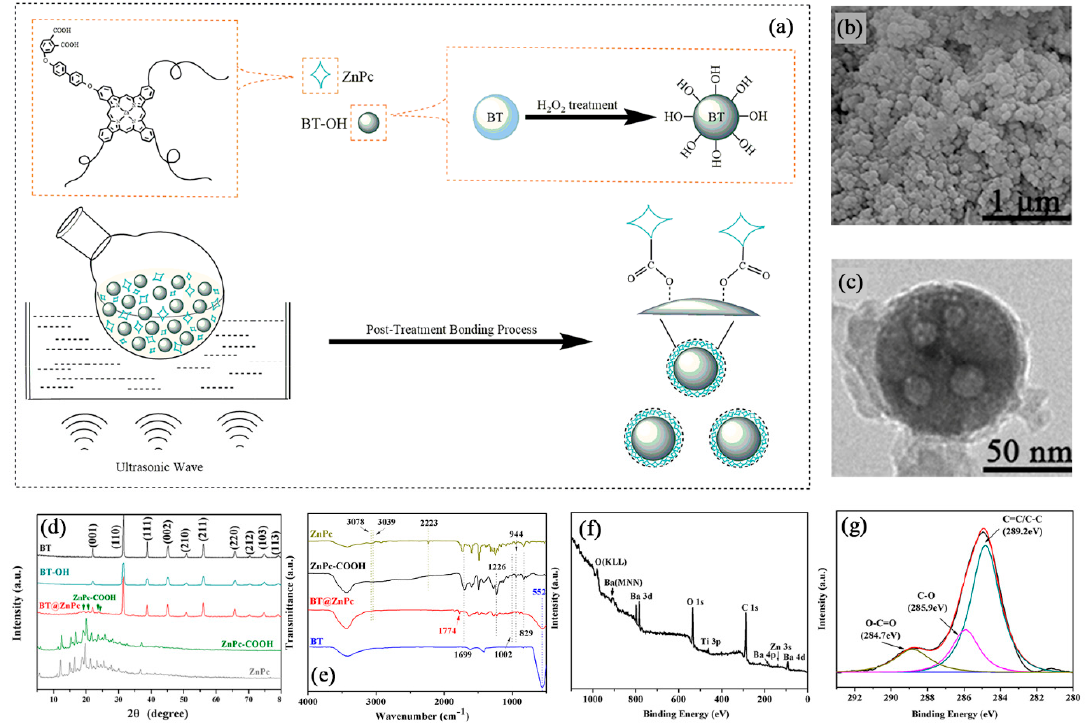
Figure 1. ( a ) Synthetic route for Barium titanate(BT)@ZnPc; ( b ) SEM image of BT@ZnPc; ( c ) TEM